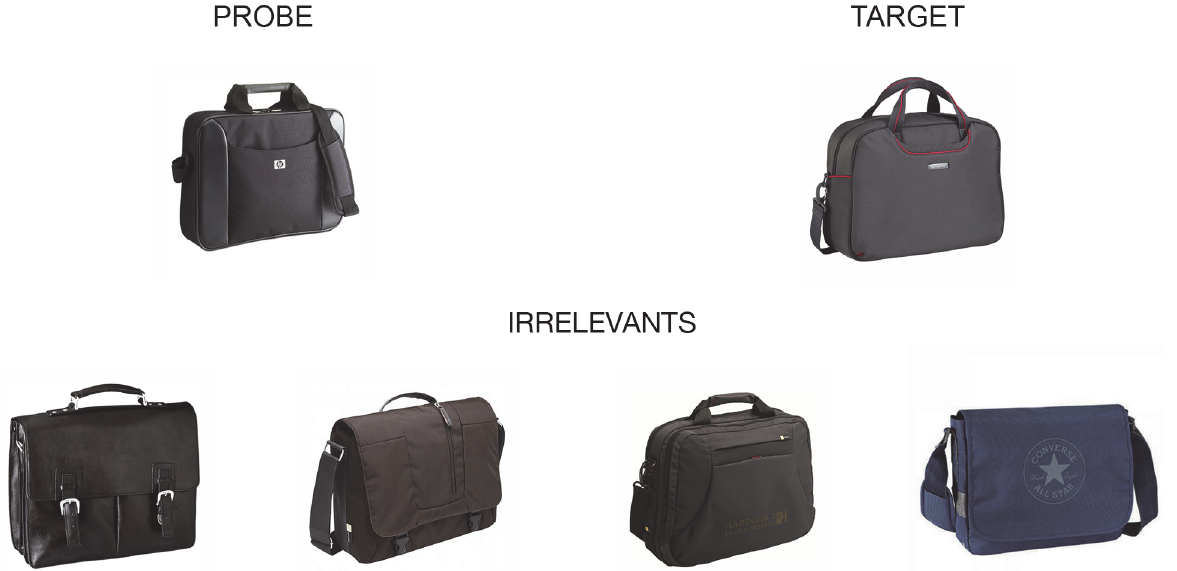
Fig 1. Sample items from the RT-based Concealed Information